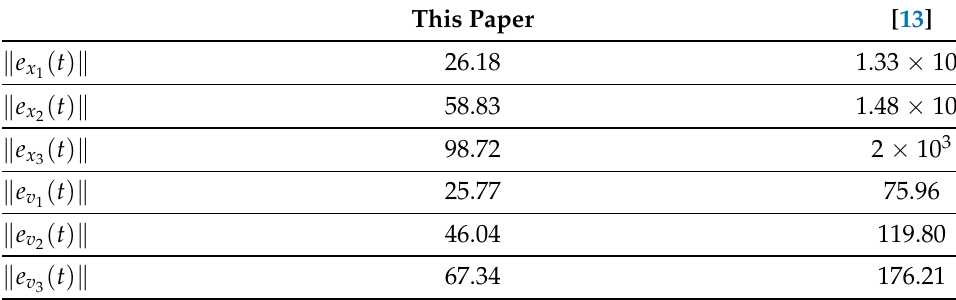
Table 1. The 2-norms of the tracking errors of the position and